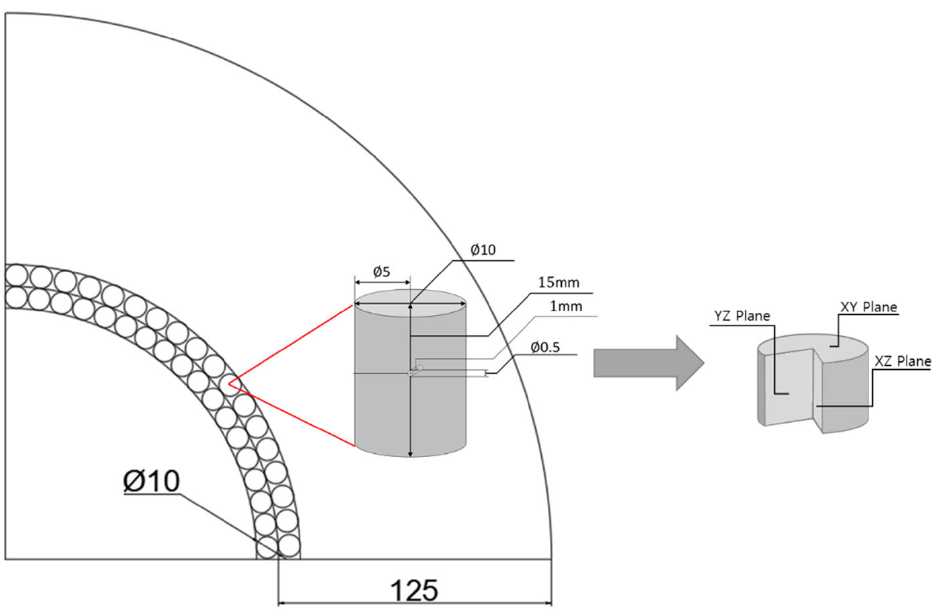
Figure 1. Schematic position diagram for the high-temperature compression samples in the as-received Ti-6Al-4V alloy.